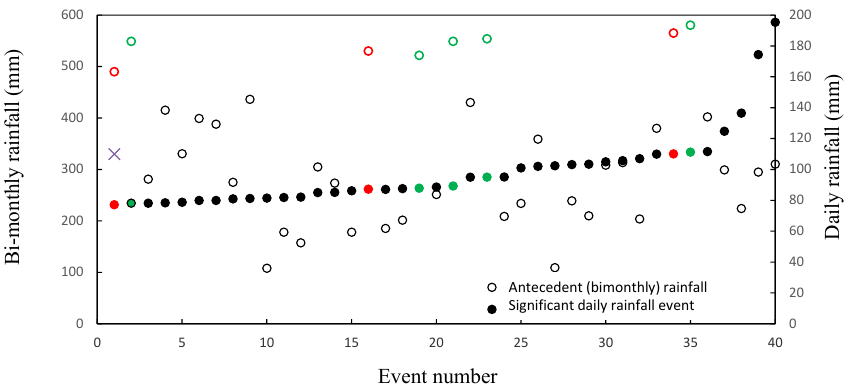
Figure 3. Daily and antecedent bimonthly rainfall recorded at the Nocera Inferiore site and corresponding to significant events (red circles are associated with landslide triggering and green circles with rainfall histories similar to those resulting in